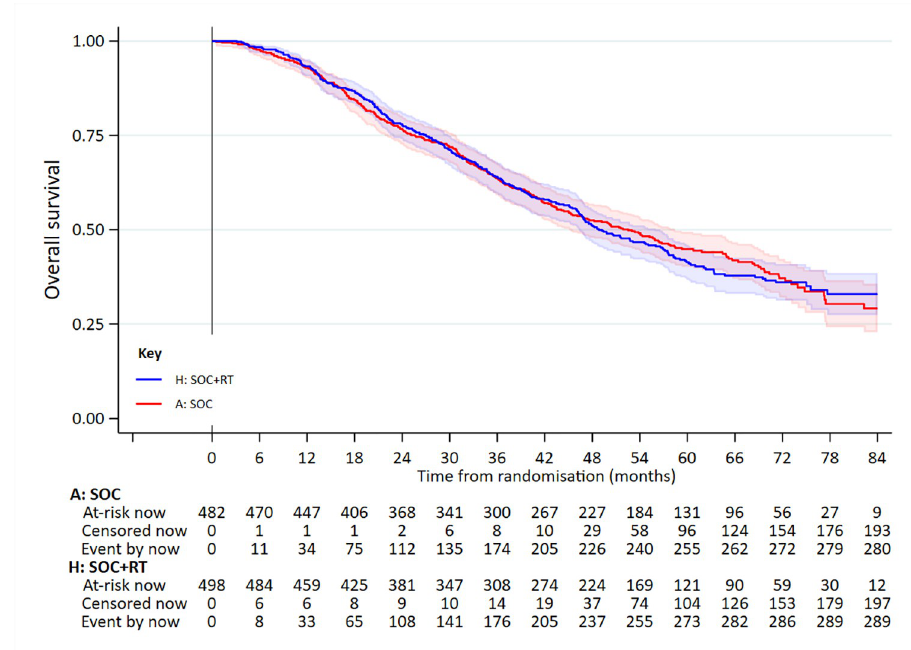
Fig 5. OS in patients nominated for weekly RT (36 Gy/6 f) prior to randomisation. Adjusted HR = 1.00 (95% CI 0.85 to 1.18; p = 0.974). HR, hazard ratio; OS, overall survival; RT, radiotherapy to the prostate; SOC, standard of care.